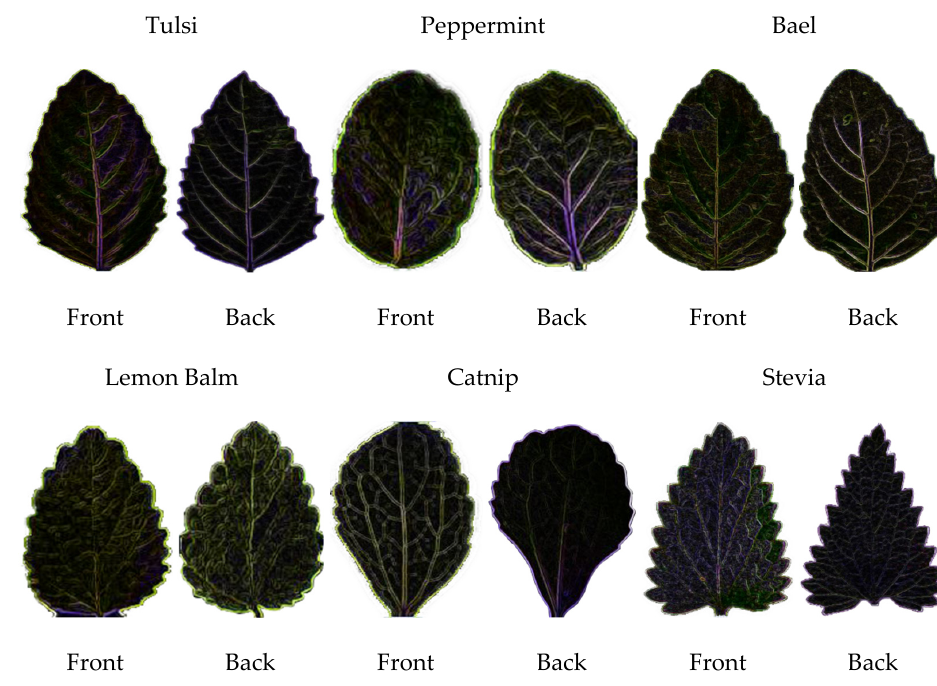
Figure 3. Sample of Transformation RGB to edge/line detection process.